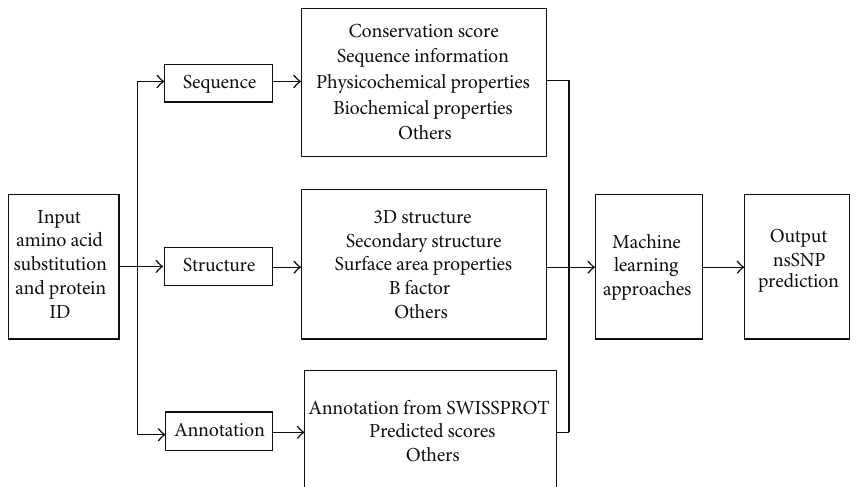
F 2: Typical procedure for deleterious nsSNPs